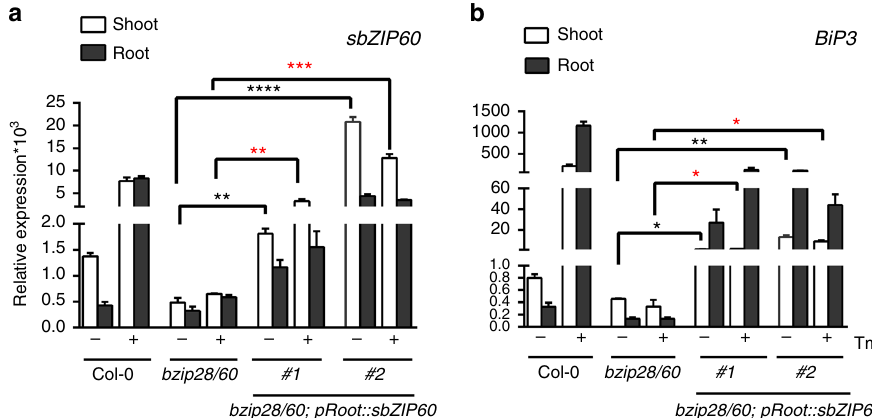
Fig. 2 Root-expressed sbZIP60 transcripts are translocated to the shoot. a , b Quantitative RT-PCR analyses of sbZIP60 ( a ) and BiP3 ( b ) in 14-day-old wild type (Col-0), bzip28/60 , and bzip28/60; pRoot::sbZIP60 seedlings treated with DMSO or 0.5 µ M Tm (Tunicamycin) at the root in the shoot – root split system for 24 h. Transcription of UBQ10 was used as internal control. Error bars represent s.e.m among three biological replicates. Data signi fi cantly different from the corresponding control are indicated by asterisks (* P < 0.05, ** P < 0.01, *** P < 0.001, **** P < 0.0001; Unpaired t -test). Black asterisks designate differences between bzip28/60 and bzip28/60; pRoot::sbZIP60 lines under Tm non-treatment condition. Red asterisks designate differences between bzip28/60 and bzip28/60; pRoot::sbZIP60 under Tm treatment